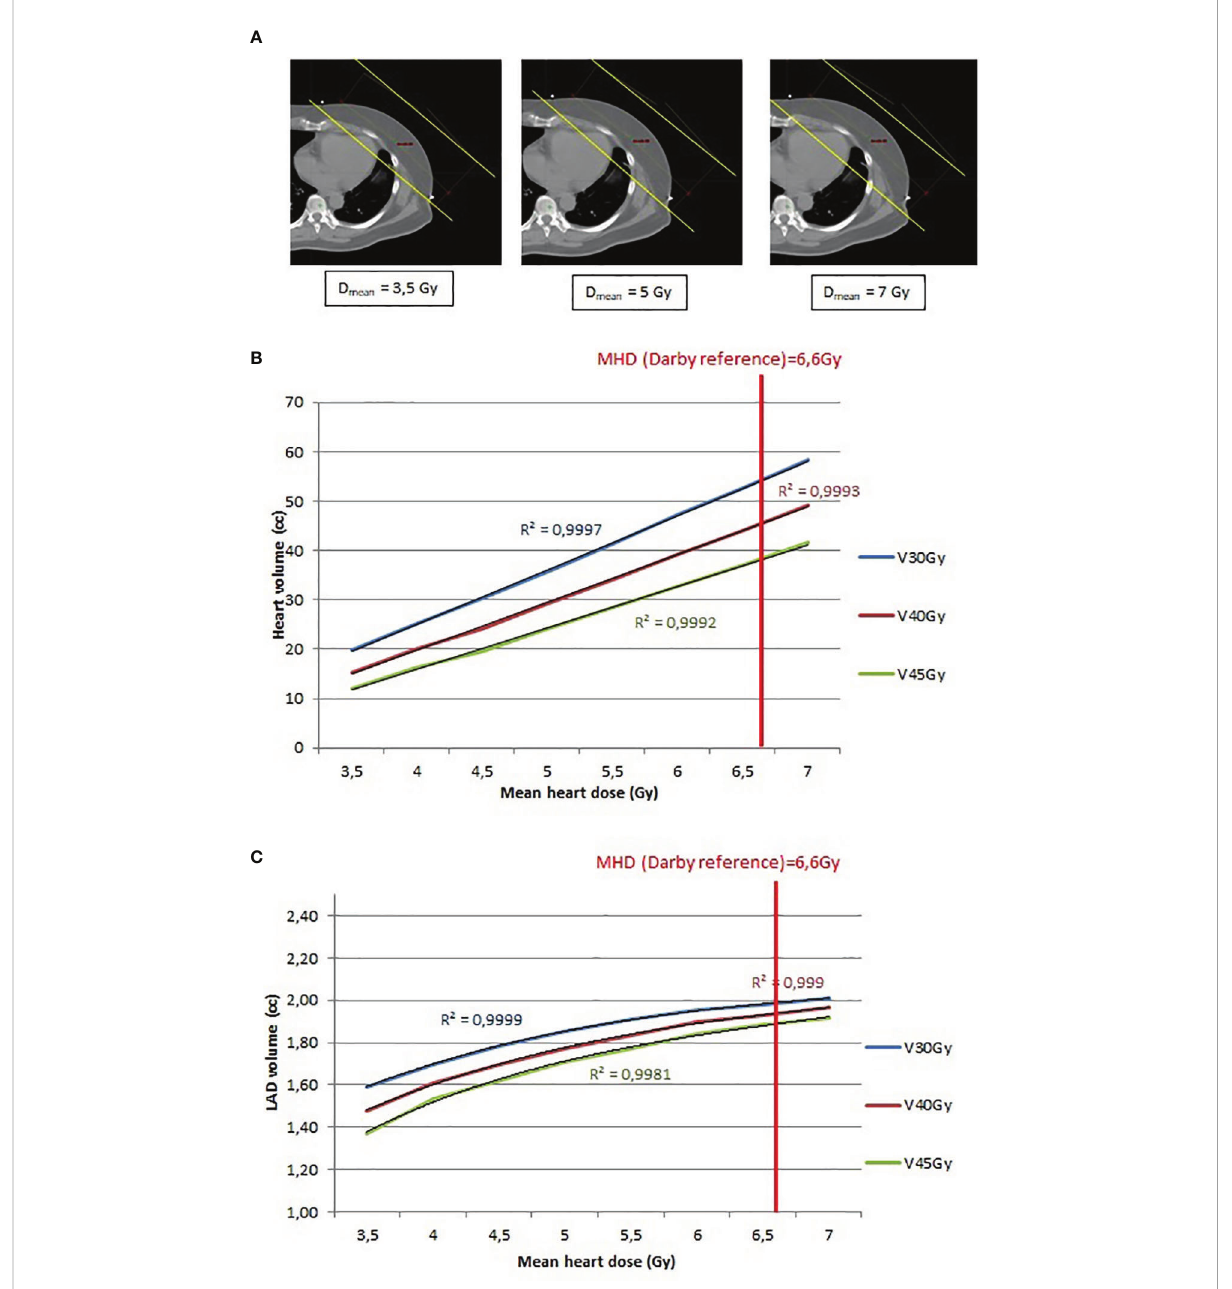
FIGURE 4 (A) Example of 3D tangent fi elds (yellow lines) plan recalculation to obtain a MHD between 3.5Gy and 7Gy, by step of 0.5Gy. (B) Relationship between heart volume (cc) and mean heart dose (Gy) and determination of the R 2 value. (C) Relationship between LAD coronary artery volume (cc) and mean heart dose (Gy) and determination of the R 2